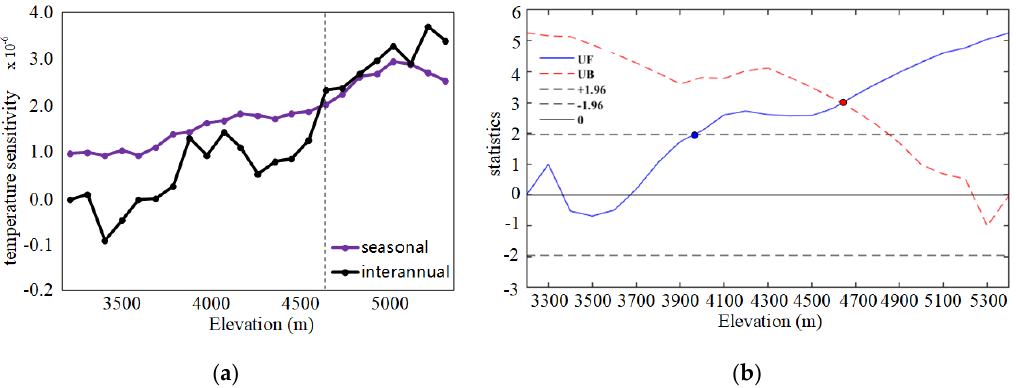
Figure 7. ( a ) Altitudinal variation in temperature sensitivity at seasonal and interannual scale. ( b ) Mann–Kendall test result of interannual temperature sensitivity along altitude gradient; no abrupt point was detected. Red dots indicate abrupt points of temperature sensitivity; blue dots indicate altitude threshold of significant increase in temperature sensitivity. Unit of temperature sensitivity is nm –1 sr –1 K –1 .